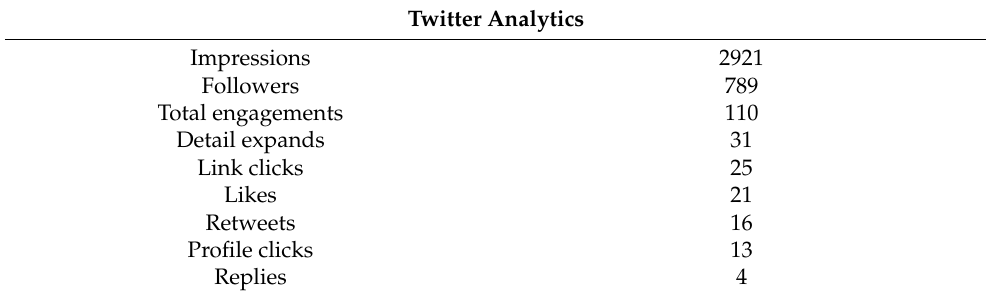
Table 2. Twitter analytics from survey Twitter posts 1 .